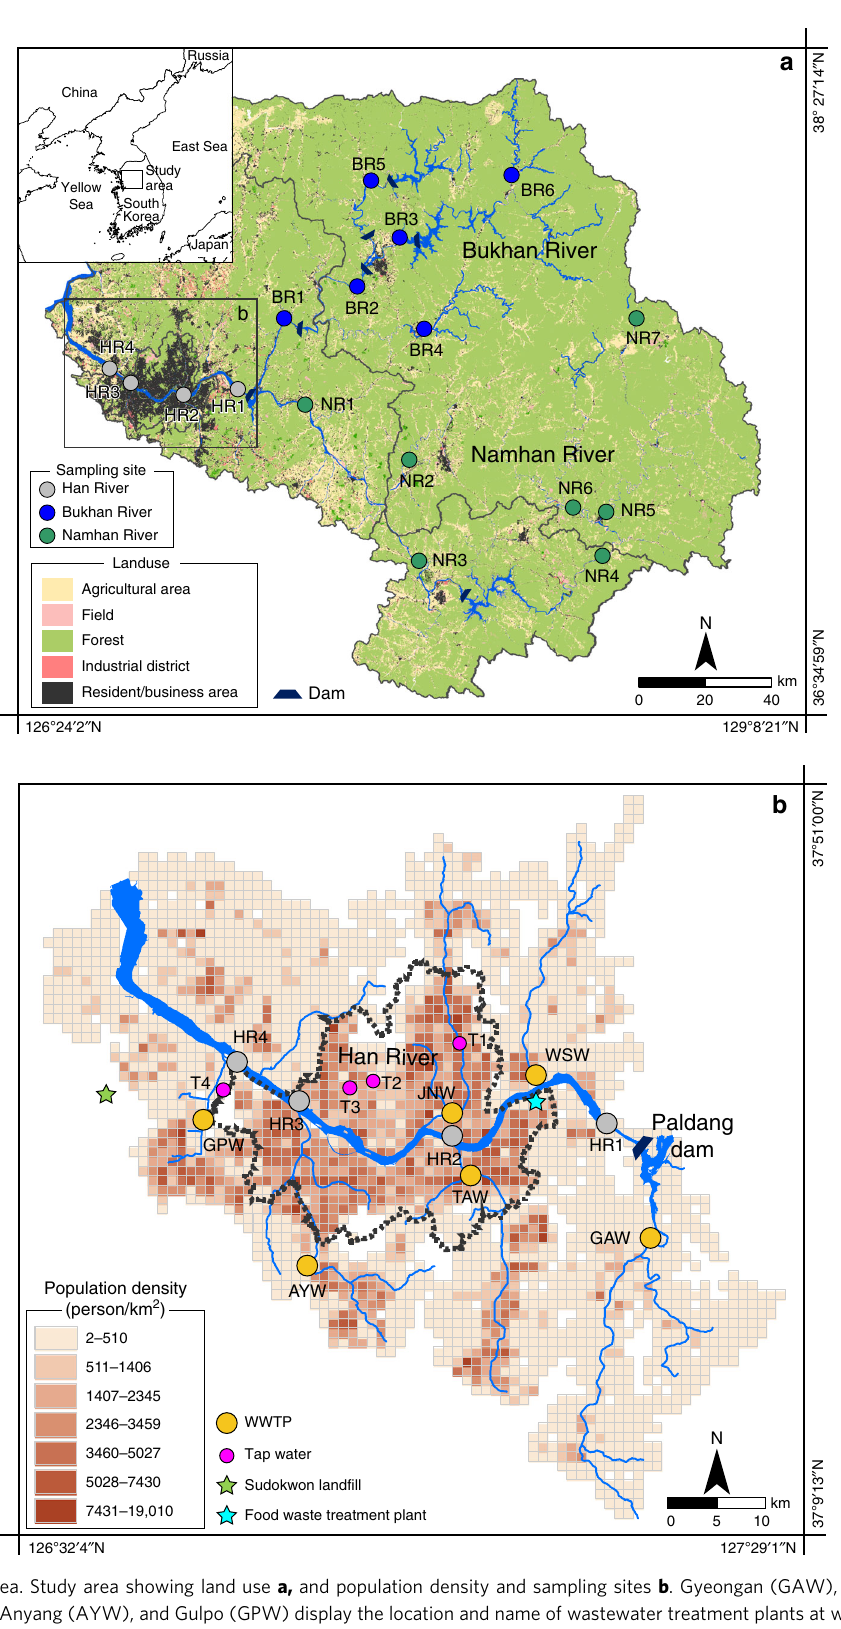
Fig. 1 Map of the study area. Study area showing land use a, and population density and sampling sites b . Gyeongan (GAW), Wangsuk (WSW), Tan (TAW), Jungnang (JNW), Anyang (AYW), and Gulpo (GPW) display the location and name of wastewater treatment plants at which the wastewater was collected. Note that the HR4 site is located at ~30 km distance from the